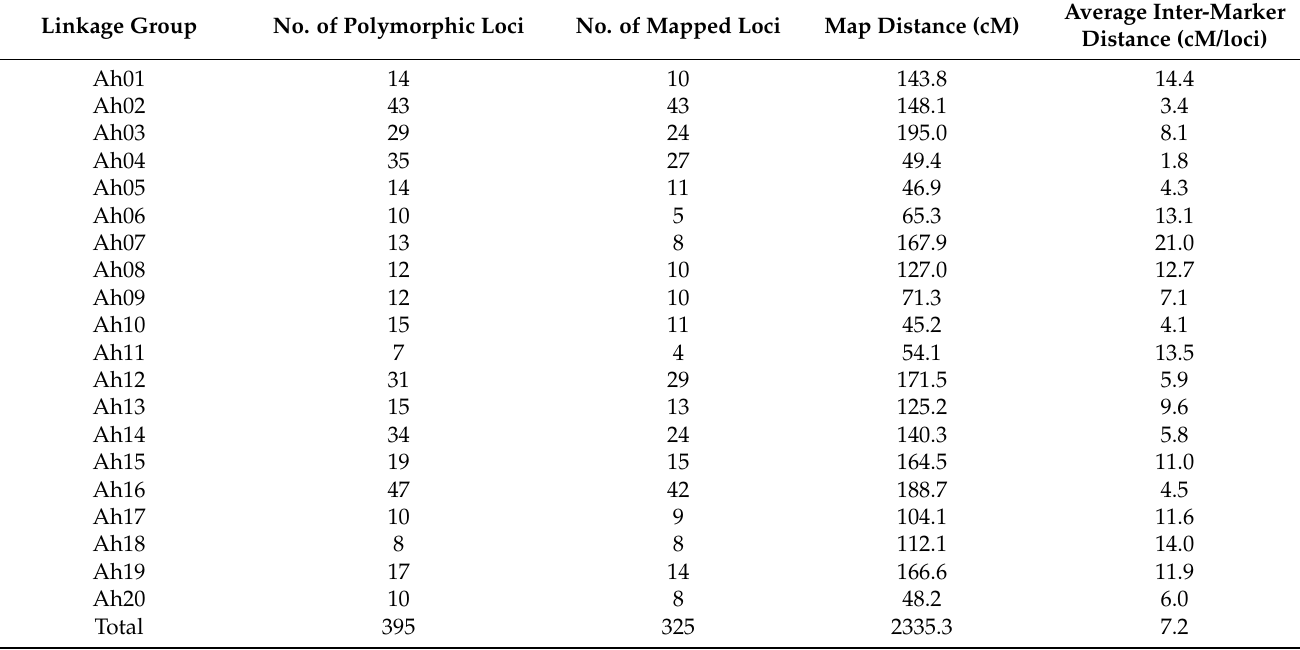
Table 1. Summary of the genetic linkage map with 325 mapped SNP loci in RIL population (ICGV 02266 × ICGV